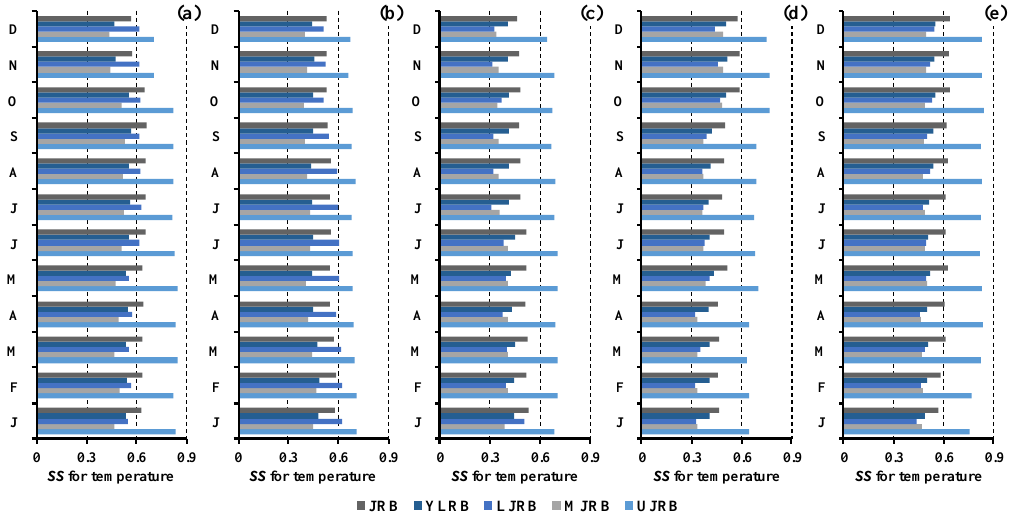
Figure 10. Skill score for precipitation simulation: GFDL-ESM2M ( a ); HADGEM2-ES ( b ); IPSL-CM5A-LR ( c ); MIROC-ESM-CHEM ( d ); NORESM1-M ( e ).